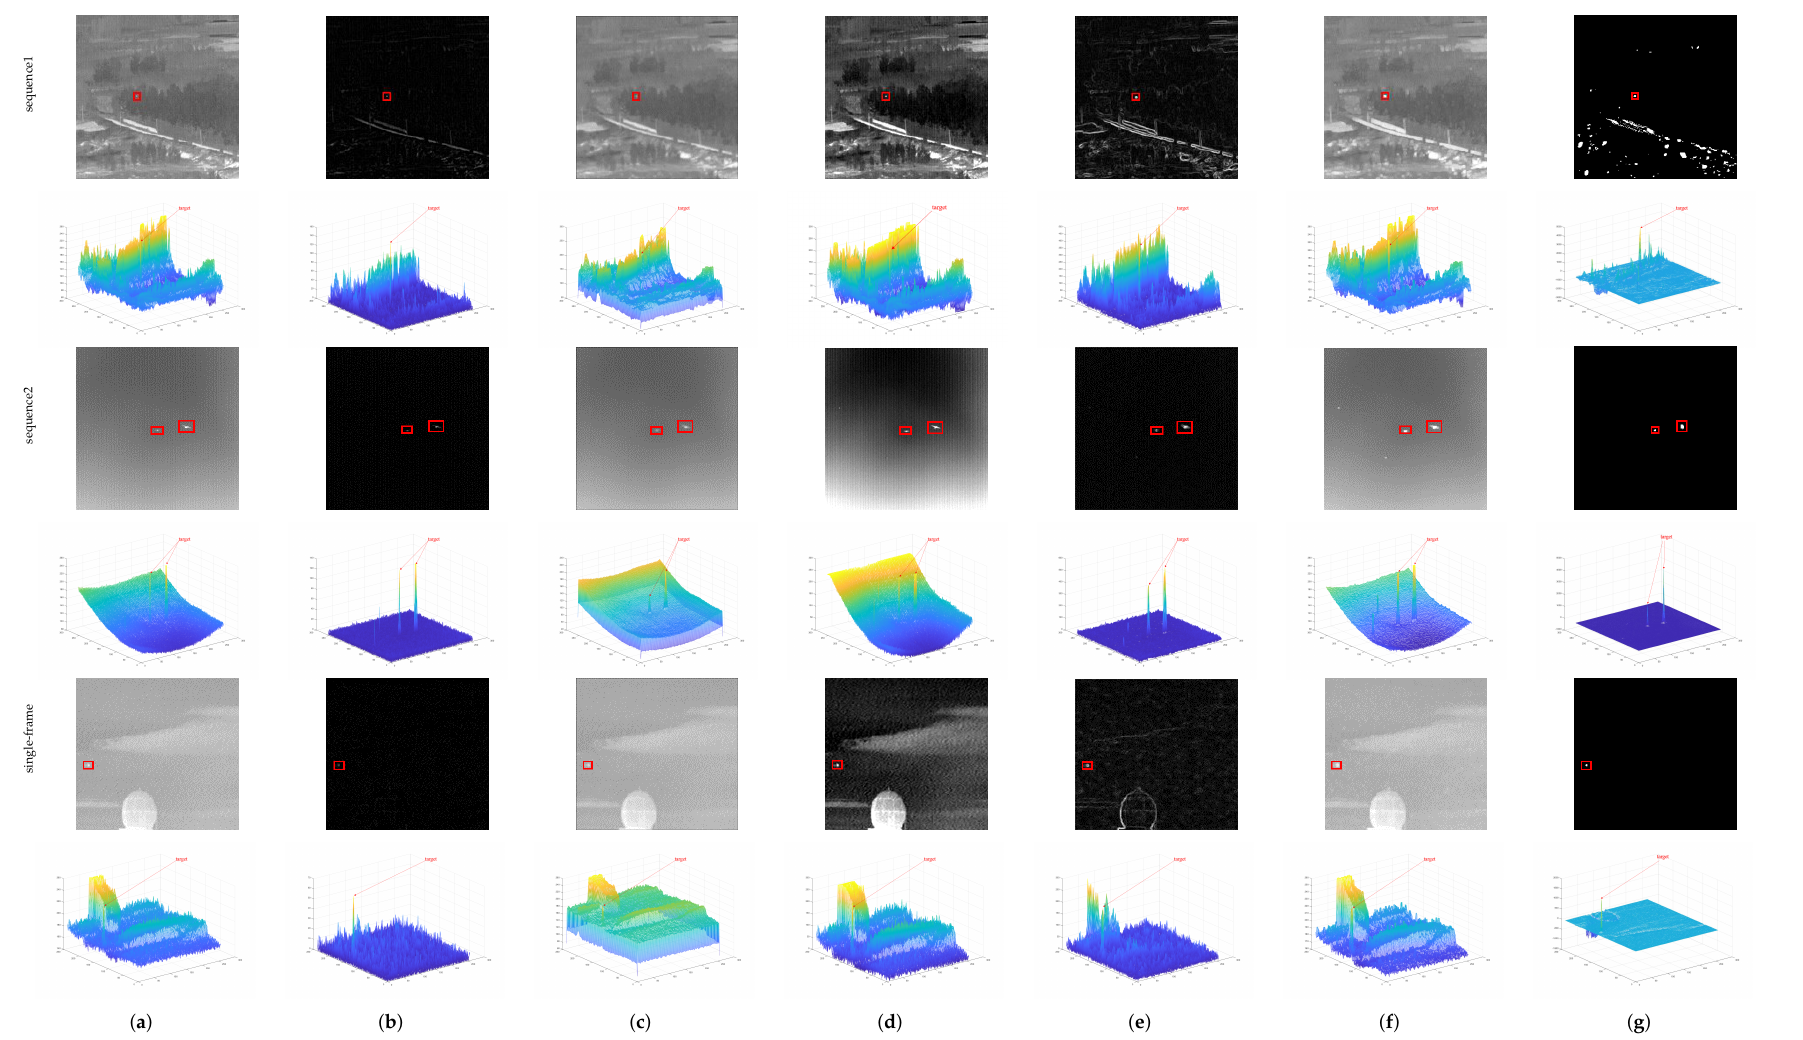
Figure 8. Results and 3D graphs of different filtering methods for multiple datasets. ( a ) Original; ( b ) Top-hat; ( c ) Mean-filter; ( d ) Contrast enhancement; ( e ) Gradient; ( f ) Maximum; ( g )